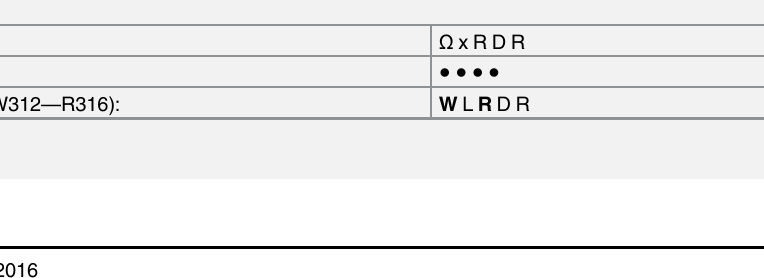
Box 1. The search motif Ω xRDR used for in silico screening. ‘ Ω ’ represents an aromatic amino acid and ‘ x ’ is any residue. The bottom row indicates the corresponding residues in